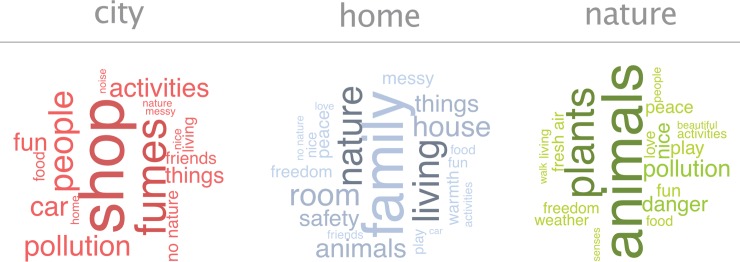
Word clouds of themes for city, home, and nature.The themes are reported more than three times. The size of the words is weighted for how many times the theme reoccurs in children’s answers.